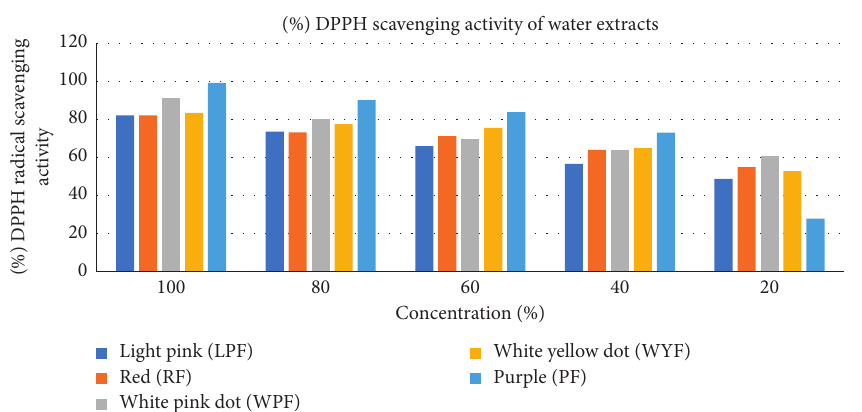
Figure 17: IC50 of the water extracts.